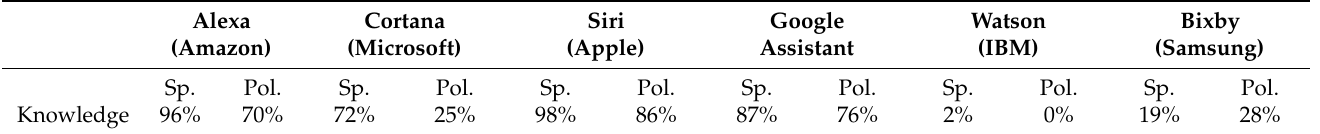
Table 2. Familiarity with modern chatbots (Intelligent Personal Assistants).